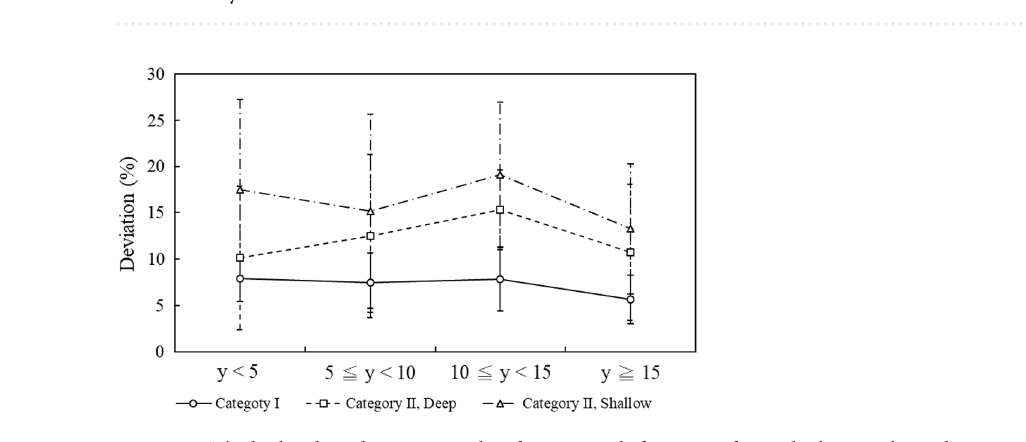
Figure 3. The badge dose deviations within four intervals for years of use which were showed in category I, category II (deep) and category II (shallow).